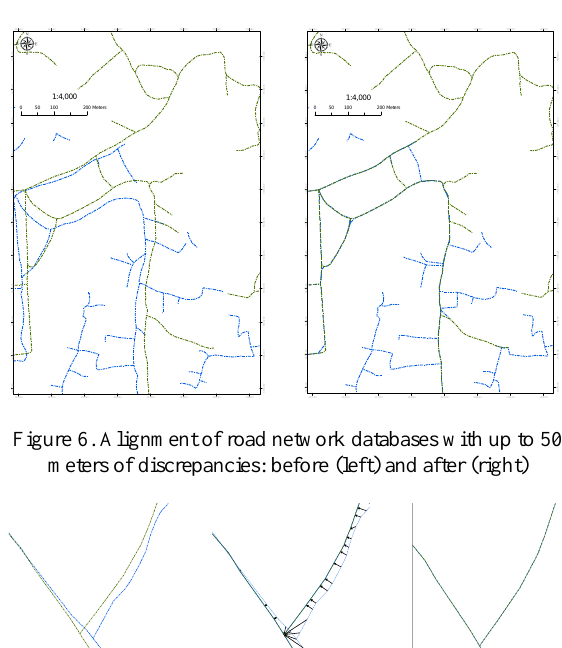
Figure 5. Geometric alignment of cadastral databases along the border of two neighbouring states: before (left) and after (right) Figure 6 depicts the alignment of linear features derived from a road network: subject in dashed blue and reference in dashed green. The left image depicts an extract of the data showing geometric discrepancies of up to 50 meters before the implementation. The right image depicts the alignment results, presenting almost a complete geometric overlay and consistency of corresponding features. The overall alignment result is robust and accurate. A detail from Figure 6 is depicted in Figure 7: before (left), during (middle, including vector fields as black arrows), and, after (right) implementation. The vector fields are derived from the local geometric spatial displacements extracted. Perfect alignment of linear features is clear (right): subject dataset overlays seamlessly with the reference one.